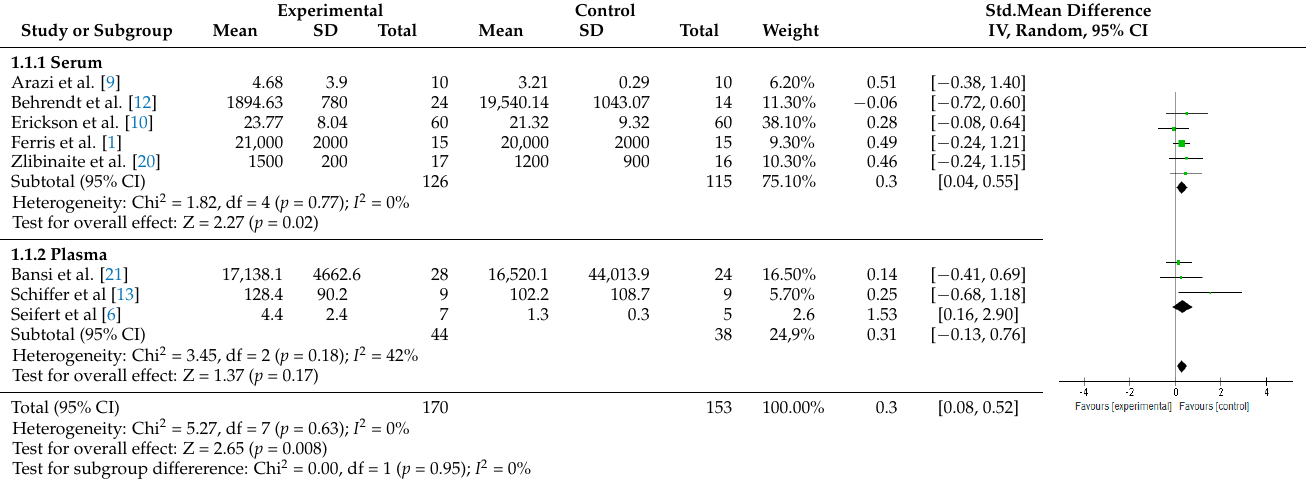
Table 4 shows the SMD for the difference between the BDNF values in serum and BDNF values in plasma between the endurance exercise and the control groups. The subgroup analysis confirmed that endurance exercise significantly benefits the BDNF levels in the serum [1,9,10,12,20]. All SMD values in the serum subgroup were <1.0. The CI for the BDNF values in serum crossed 1.0, suggesting wide variation in values. All five studies in the serum averaged were statistically significant (SMD = 0.30; 95% CI = [0.04, 0.55]; p = 0.02). Based on the I 2 index ( I 2 = 0%), the studies were homogenous in terms of variability. All SMD values in the plasma subgroup were <1.0, with one study (Seifert et al.) reaching statistical significance. The CI for the BDNF values in plasma crossed 1.0, suggesting wide variation. All three studies averaged were not statically significant (SMD = 0.31; 95% CI = [ − 0.13, 0.76]; p = 0.17) [6,13,21]. The tests for heterogeneity in the plasma subgroup were not statistically significant ( χ 2 = 3.45, p = 0.18, I 2 = 42%). Table 4. Standardized mean differences and forest plot of impact of endurance exercise on BDNF levels in serum and plasma. Experimental Control